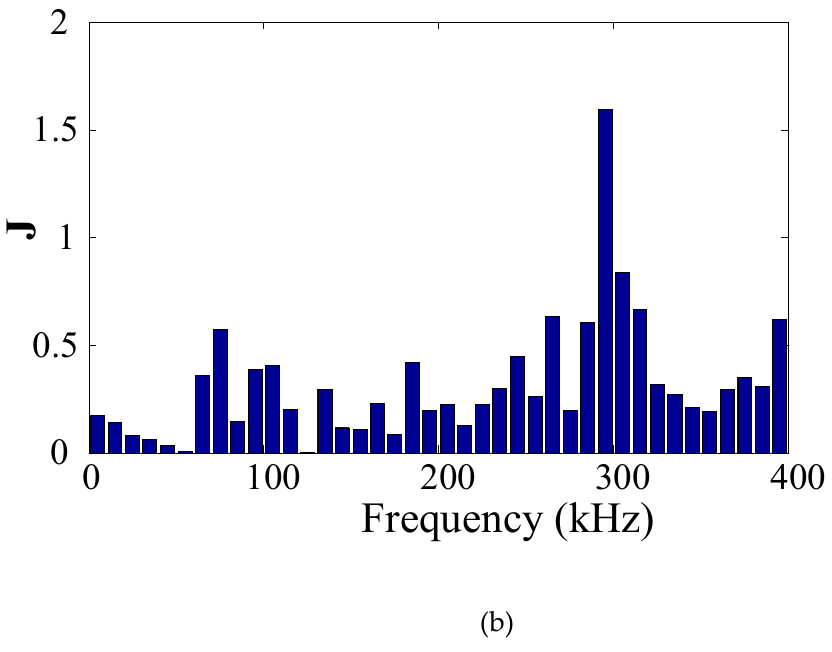
Figure 10. Raw signal and classification index for frequency features ( a ) raw signal for index calculation ( b ) classification index (signals collected in the first millisecond of laser operation).